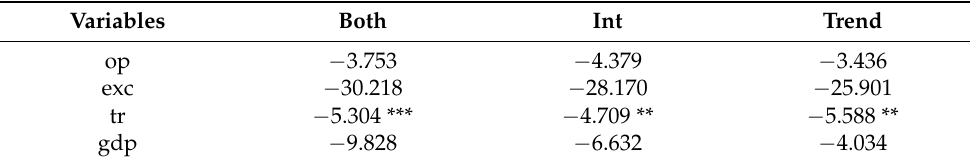
Figure A1: Plots of the used variables, normalized scale. Figure A1. Plots of the used variables, normalized scale. Table A1. Zivot–Andrew Unit tests results. Table A1. Zivot–Andrew Unit tests